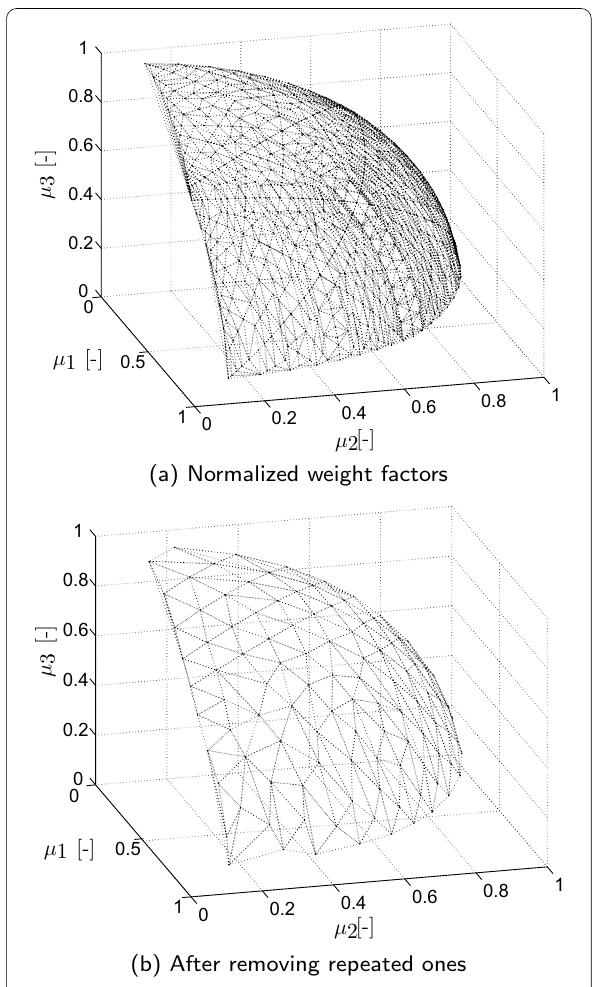
Figure 2 Generation of optimally distributed weight